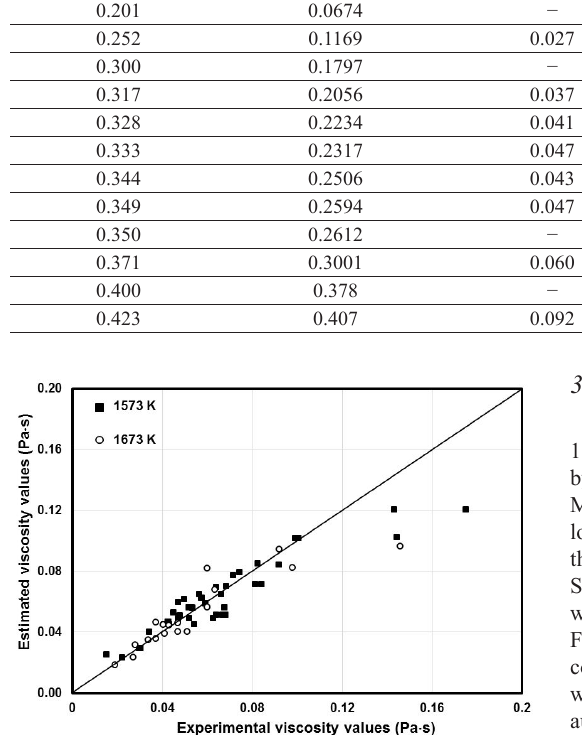
Table 4. Experimental and calculated viscosities of the SiO X SiO2